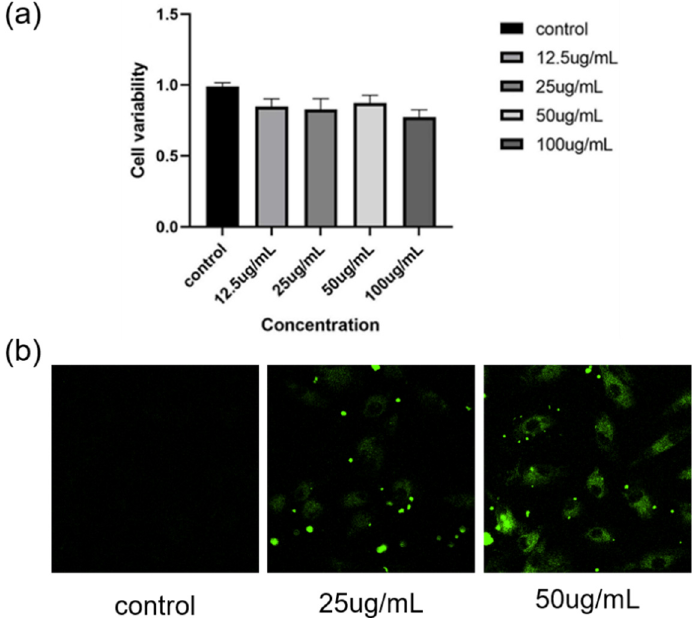
Figure 5. ( a ) In vitro U87 cytotoxicity profiles of C A . Mean values and error bars were defined as mean and s.d., respectively. Experiments were performed in triplicate. ( b ) CLSM images of viable cell distributions after co-incubation with C A at varied concentrations: 0, 25, and 50 μ g/mL for 4 h.